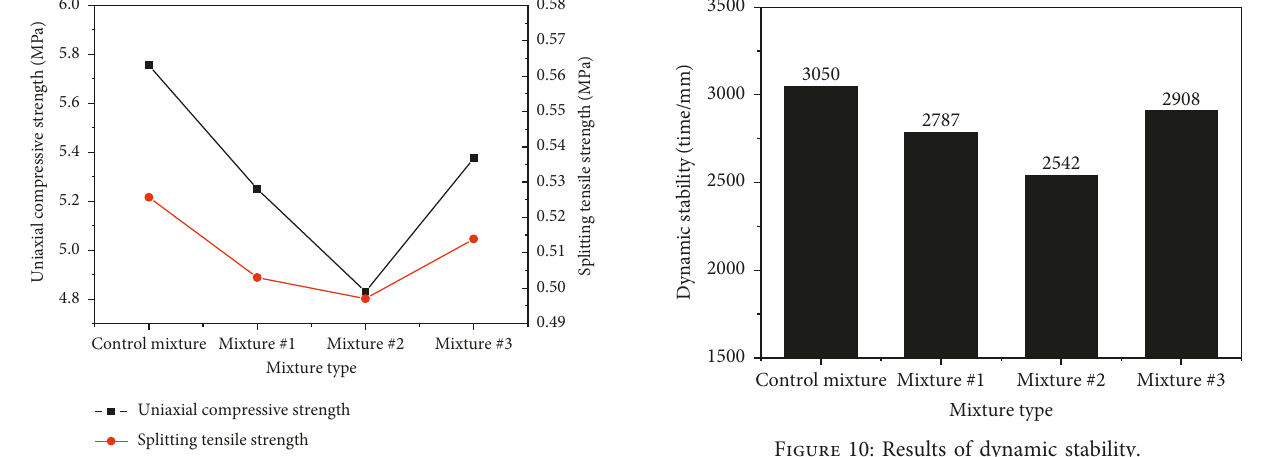
Figure 8: Results of uniaxial compression strength and splitting tensile strength.